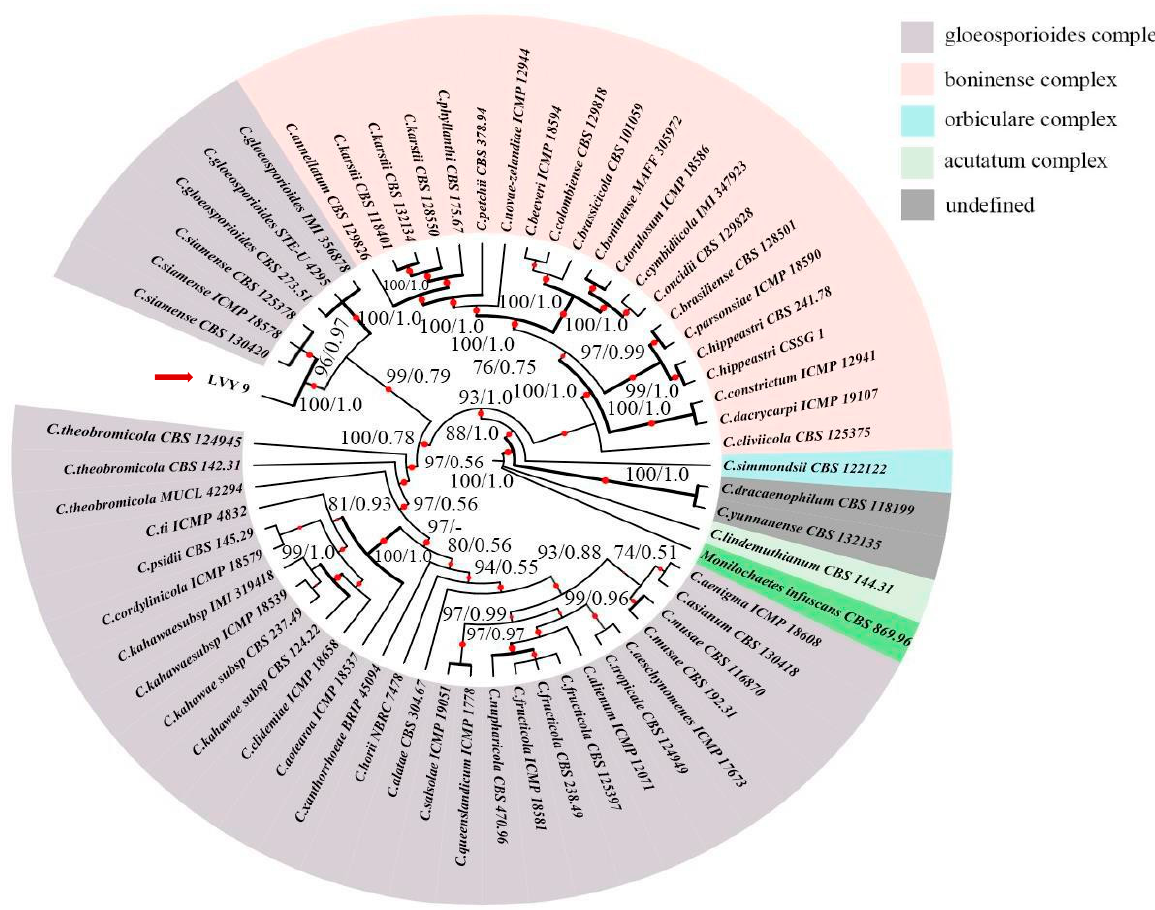
Figure 4. Maximum likelihood (ML) tree generated from the combined ACT, CAL, CHS-1, GAPDH and ITS sequence data of 59 taxa of Colletotrichum , of which 21 are in C.boninense complex, 34 are in C.gloeosporioides complex, 1 is in C.orbiculare complex, 1 is in C.acutatum complex, 2 are undefined. Clades with >75% ML_BS (left) and 0.50 BI-PP (right) are indicated by the corresponding support values. Parsimony and likelihood bootstrap support values ≥ 95% are indicated at the nodes and branches with Bayesian posterior probabilities above 0.95 given in bold. The ex-type strains are in bold. Dashes indicate support values lower than 75% ML-BS and 0.50 BI-PP. The tree is rooted with Monilochaetes infuscans CBS 869.96. The red arrow points to strain LVY9.